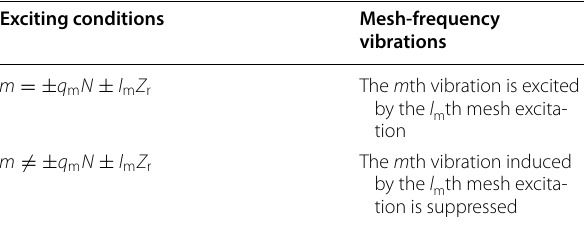
Table 1 Exciting conditions for elastic mesh-frequency phasing